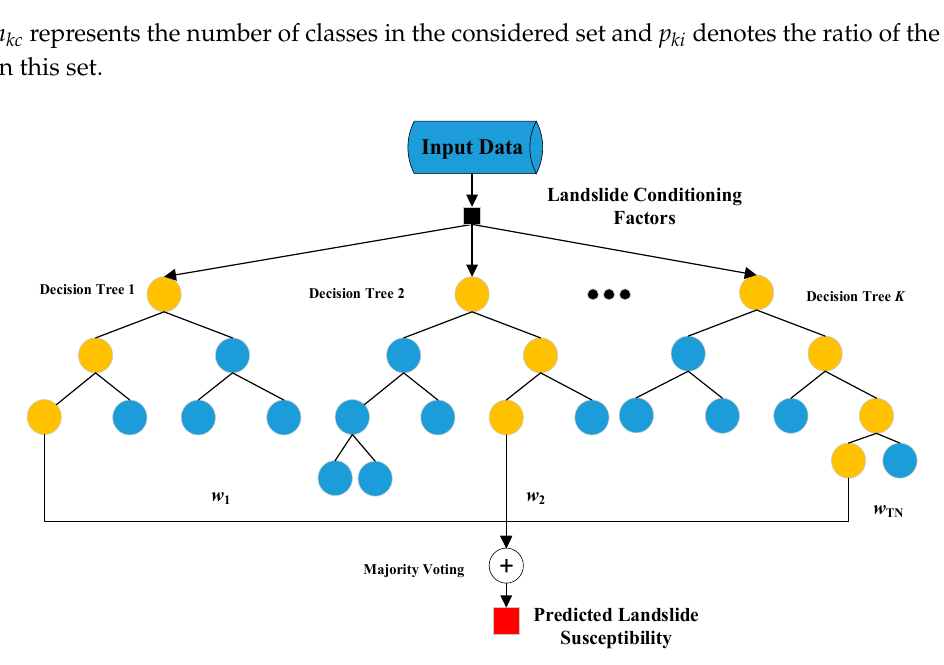
Figure 4. The general structure of the Random Forest Classifier (RFC) model in this research.